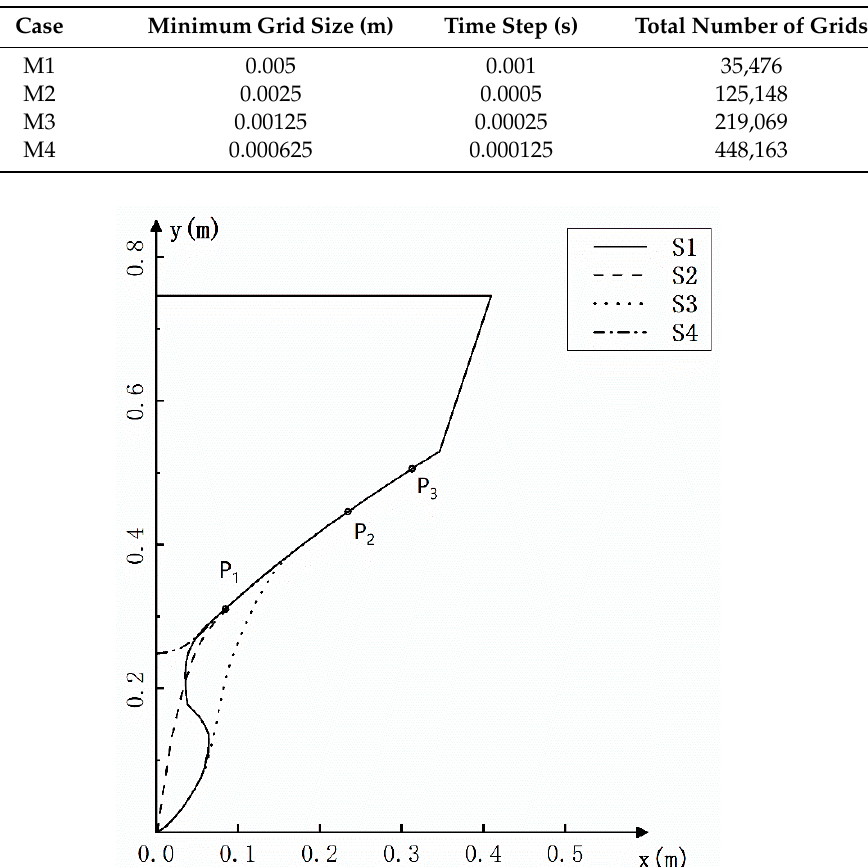
Figure 3. Several di ff erent bow-flared sections. Appl. Sci. 2020 , 10 , x FOR PEER REVIEW